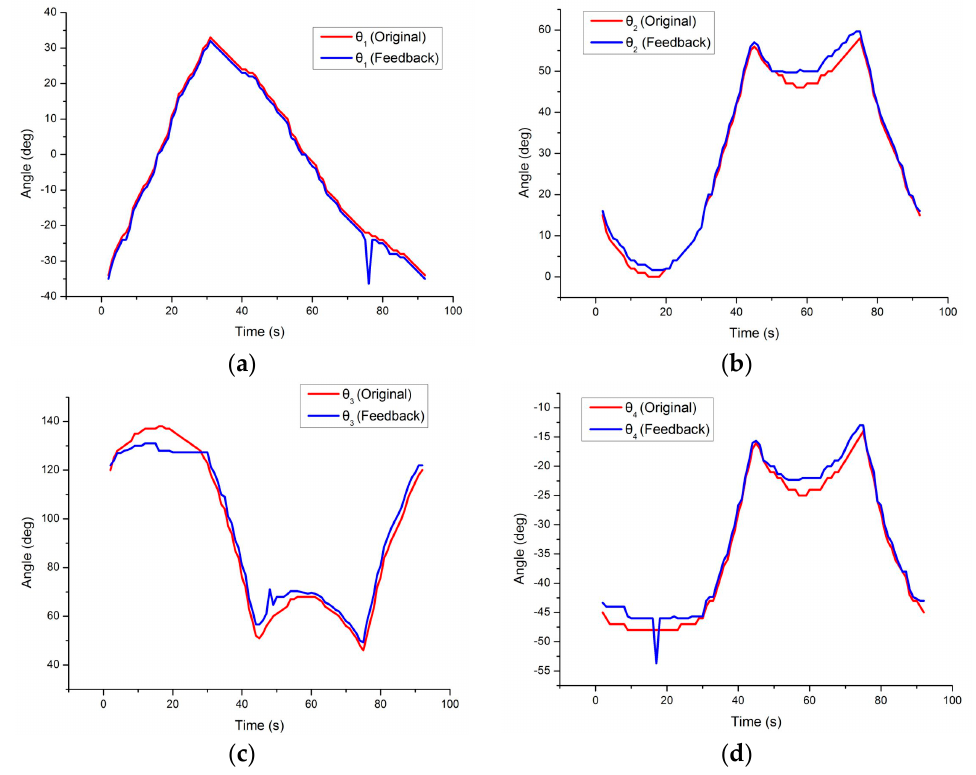
Figure 7. The robot arm moving along a given rectangular path with no payload, showing the theoretical and measured angular changes over time for each axis: ( a ) Axis-0 ( θ 1 ); ( b ) Axis-1 ( θ 2 ); ( c ) Axis-2 ( θ 3 ); ( d ) Axis-3 ( θ 4 ).